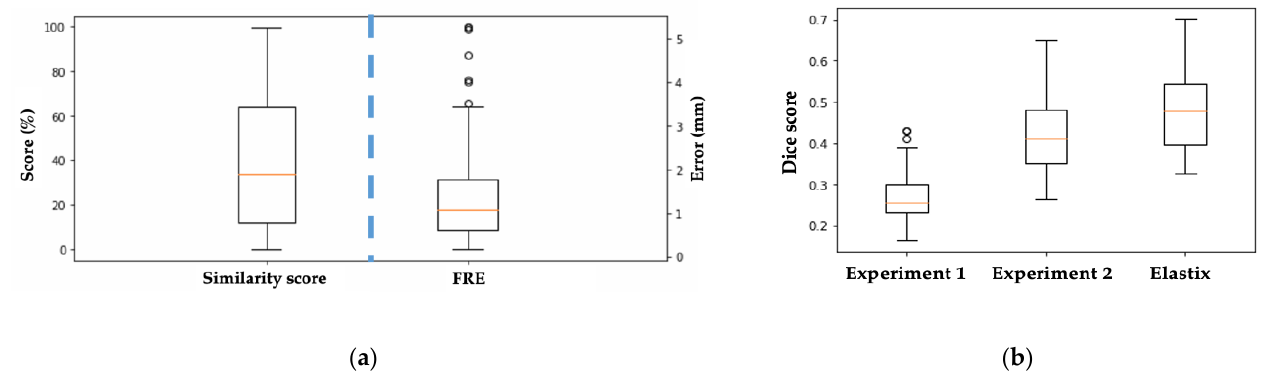
Figure 8. ( a ) Box-whisker plot showing the similarity score spread versus FRE spread for each test image across all 10 cross validation folds. ( b ) Box-whisker plot showing the dice score as a comparison for experiment 1, 2 and Elastix baseline across all 10 cross validation